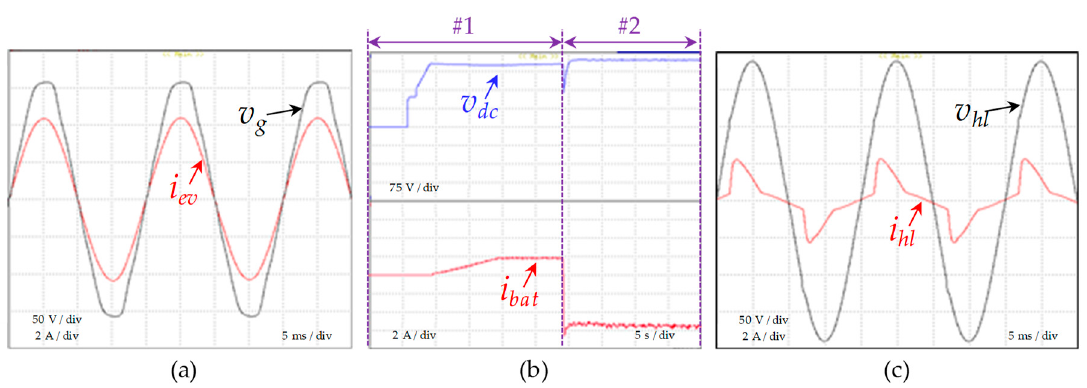
Figure 22. Experimental results of the single-phase on-board EVBC: ( a ) During 50 ms in the grid-to-vehicle (G2V) operation mode-grid-side current (i ev ) and voltage (v g ); ( b ) during 50 s in the operation as a UPS-dc-link voltage (v dc ) and battery-side current (i bat ); ( c ) During 50 ms in the operation as a UPS-produced voltage (v hl ) and consumed current (i hl ).